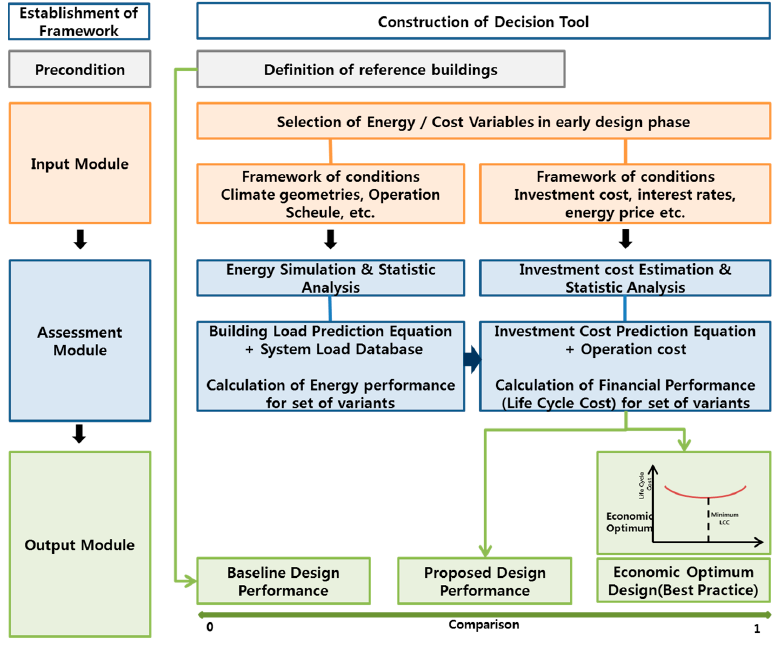
Figure 2. Framework of the Decision Tool.